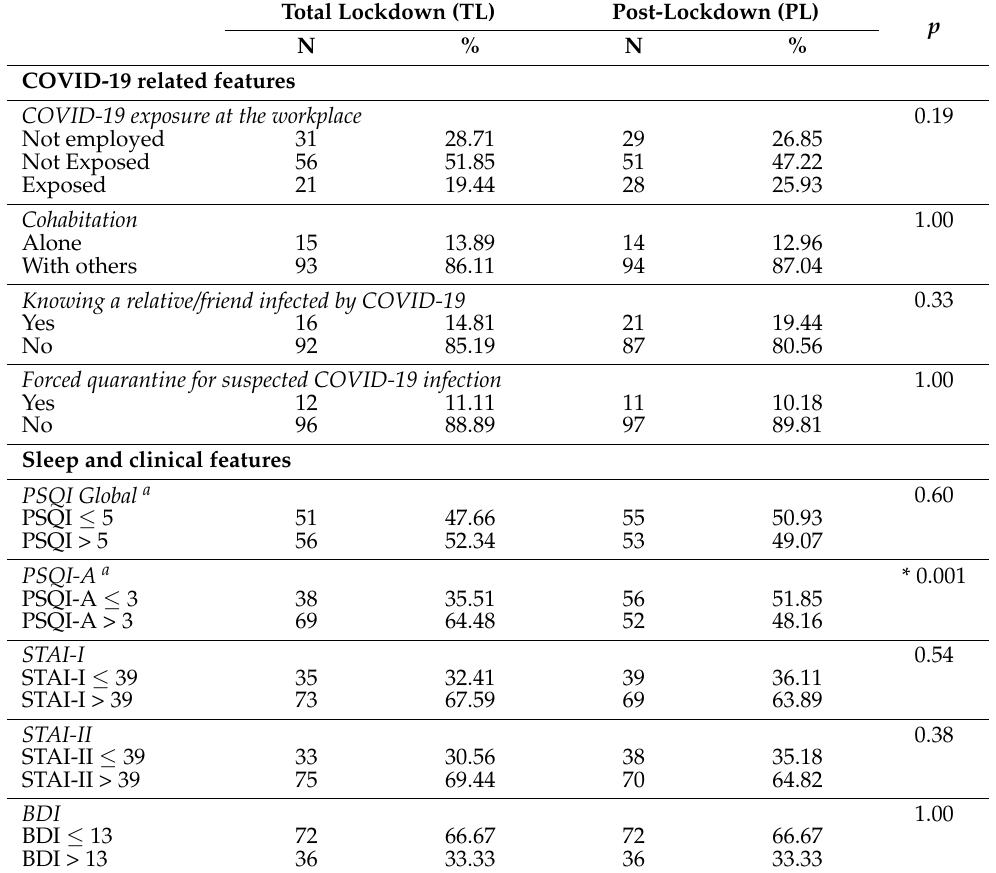
Table 3. Proportion of participants concerning COVID-19-related, sleep, and clinical variables during (TL) and after (PL) the lockdown. Results ( p -values) of the McNemar tests were also reported. The asterisk indexes a significant difference ( p < 0.05).